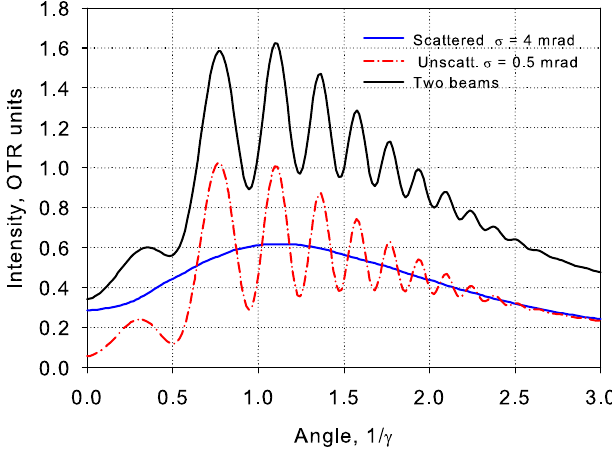
FIG. 6. (Color) Interferences produced by unscattered (red) and scattered (blue) ODR components from the mesh with OTR from the mirror and their sum (black).